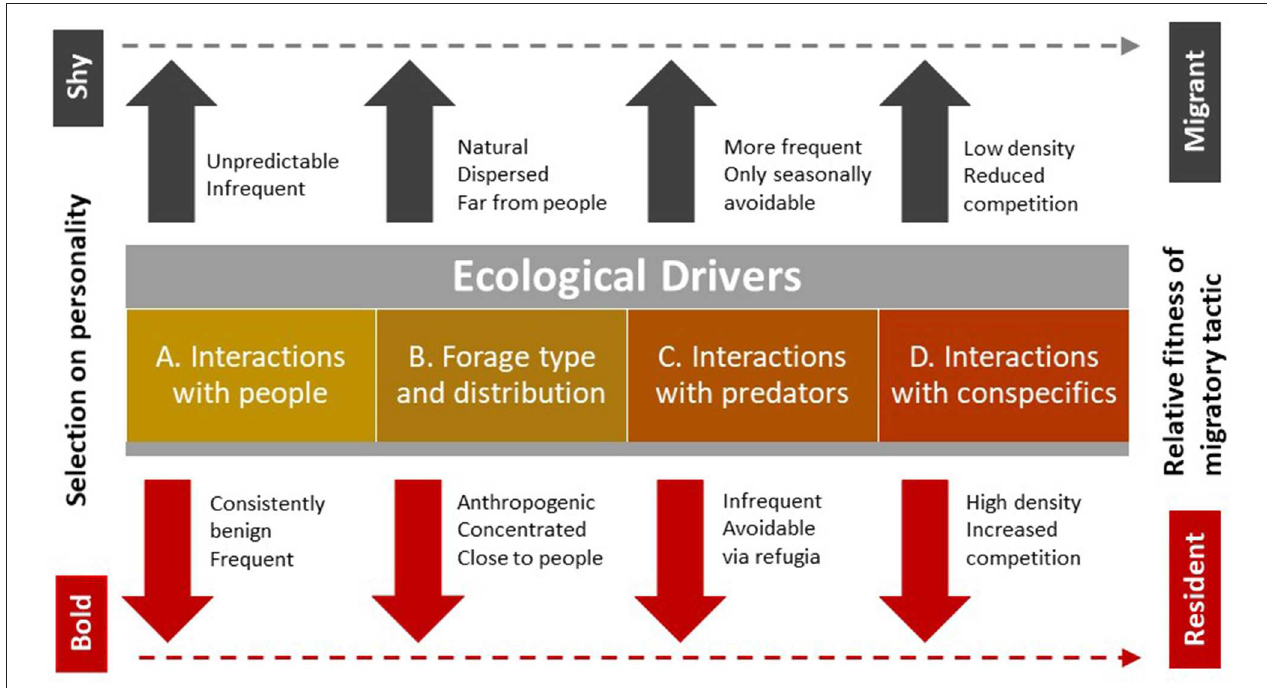
FIGURE 1 | Selection for animal personality, which we have previously described in elk on a shy-bold gradient, stems from four types of ecological drivers to influence the relative fitness of migrant vs. resident strategies. We suggest that bolder animals typically accrue more benefits than shy animals when (A) human activity is prevalent but generates consistently benign encounters, (B) novel types of anthropogenic forage are concentrated close to people, (C) predators are excluded from areas of high human density to create refugia, and (D) there is increasing competition among individuals, typically because of increased density. All of these conditions tend to favor a residency tactic (dashed line), but directional selection for bolder personalities is also mediated by the frequency of bold and shy individuals to explain the presence of a few bold migrants and shy residents. Managers could use these drivers to reduce conflict, that results disproportionately from bolder individuals, by targeting them with aversive conditioning to limit their habituation to humans, and removing or securing sources of anthropogenic forage, particularly where encounters with humans are frequent and predators are excluded. The other drivers are less amenable to manipulation because human safety limits tolerance for predators close to high densities of people and public opinion opposes culling to reduce elk